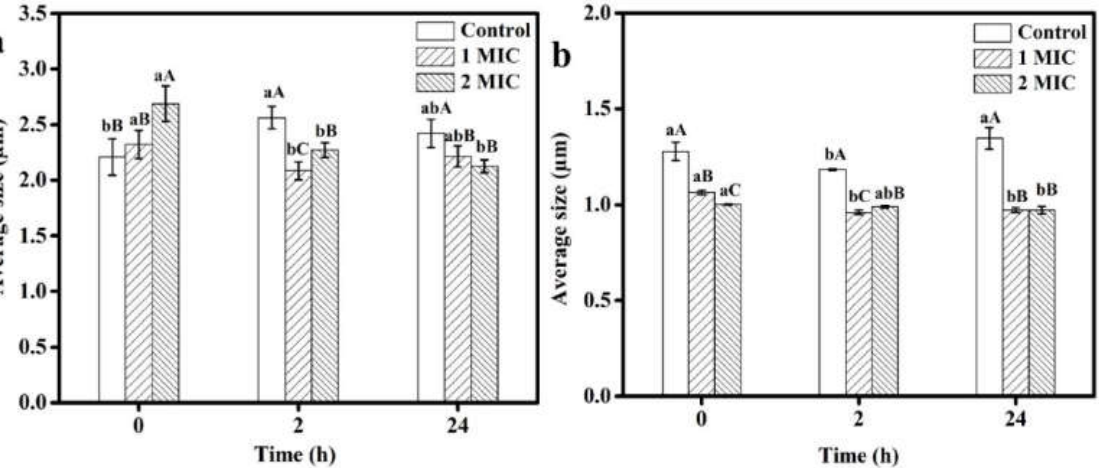
Figure 7. Average sizes of S. aureus ( a ) and P. fluorescens ( b ) cells treated with succinic acid after 0 h, 2 h and 24 h. Different lowercase letters indicate significant difference among treatments at different exposure times ( p < 0.05), while different capital letters indicate significant difference among treatments at different concentrations of succinic acid ( p < 0.05).